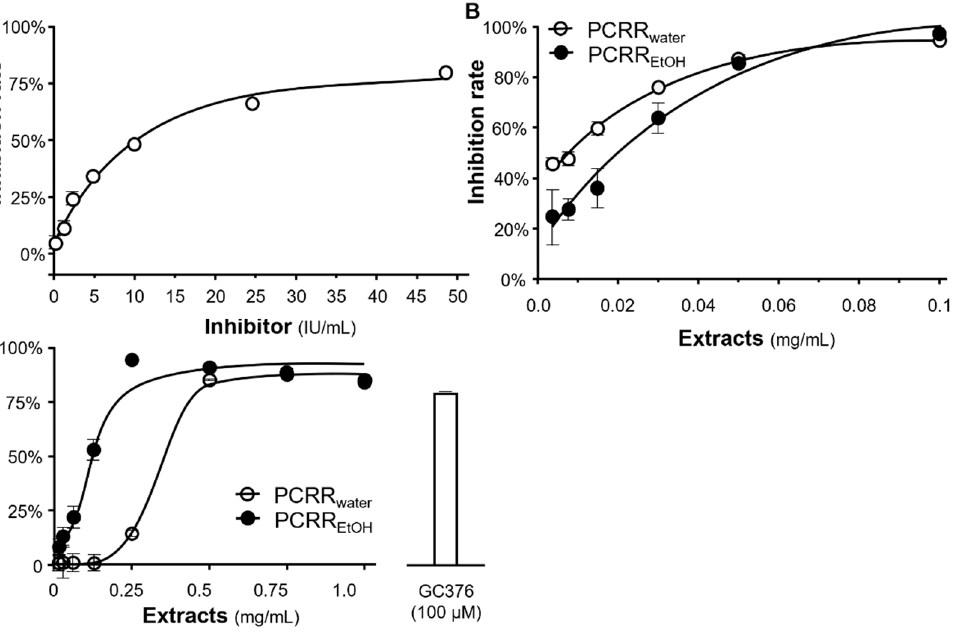
Figure 2. Effect of PCRR water and PCRR EtOH on the inhibition of S-protein-ACE2 binding and 3CL protease activity. ( A ) Line graph showing the inhibition rate of a standard inhibitor (calibrated to NIBSC code 20/136), which was employed as a positive control. ( B , C ) PCRR water and PCRR EtOH both inhibited, ( B ) S-protein-hACE2 binding, and ( C ) 3CL protease in dose-dependent manners. GC-376 served as a positive control. The inhibition rate was determined from the signal normalized to the control without the extracts. The data represent mean ± SD; n = 3.